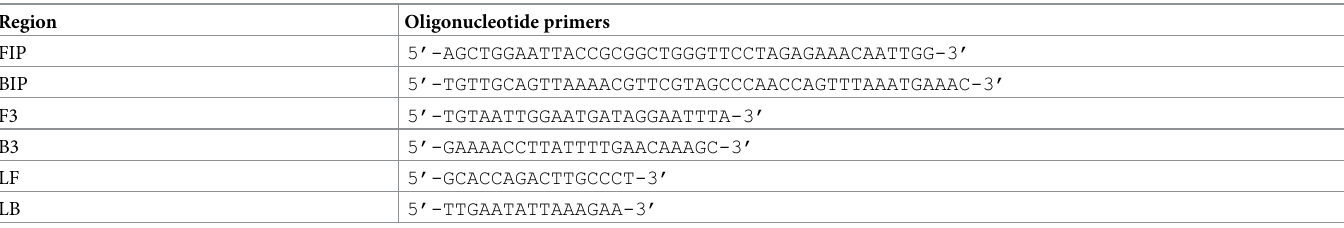
Table 1. Oligonucleotide primers used for the 18s rRNA amplification. Region